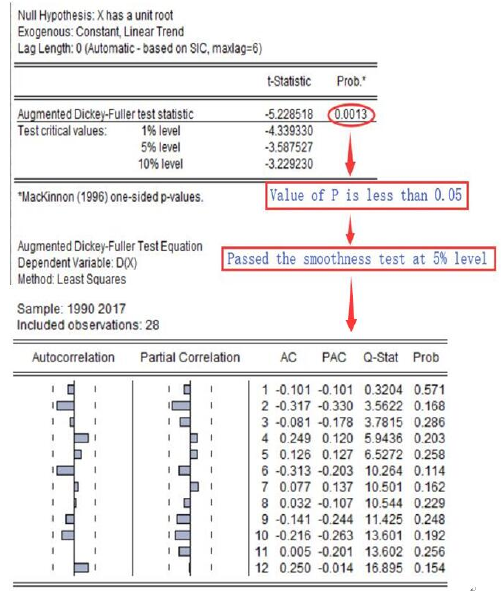
Figure 12. Stationary test result and autocorrelation (partial autocorrelation) coefficient map of MGM-ARIMA developed using Eviews 7.2.